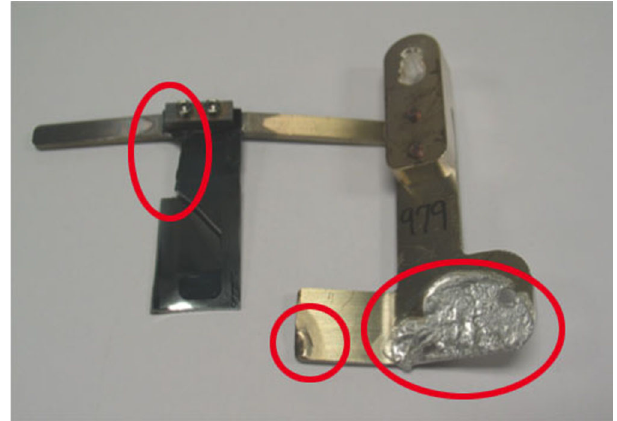
FIG. 3. A failed second-generation foil and bracket. The two lower ellipses indicate the melting damage caused by the elec- trons. The upper ellipse indicates where the silicon substrate fractured due to forces at the mounting point. This foil lasted for a few hours at (cid:2) 840 kW beam power. The convoy electrons struck the bottom-left corner of the tab on the leg of the bracket, and the subsequent heating caused the bracket to melt where the counterweight was attached. (The figure was reproduced from Ref.